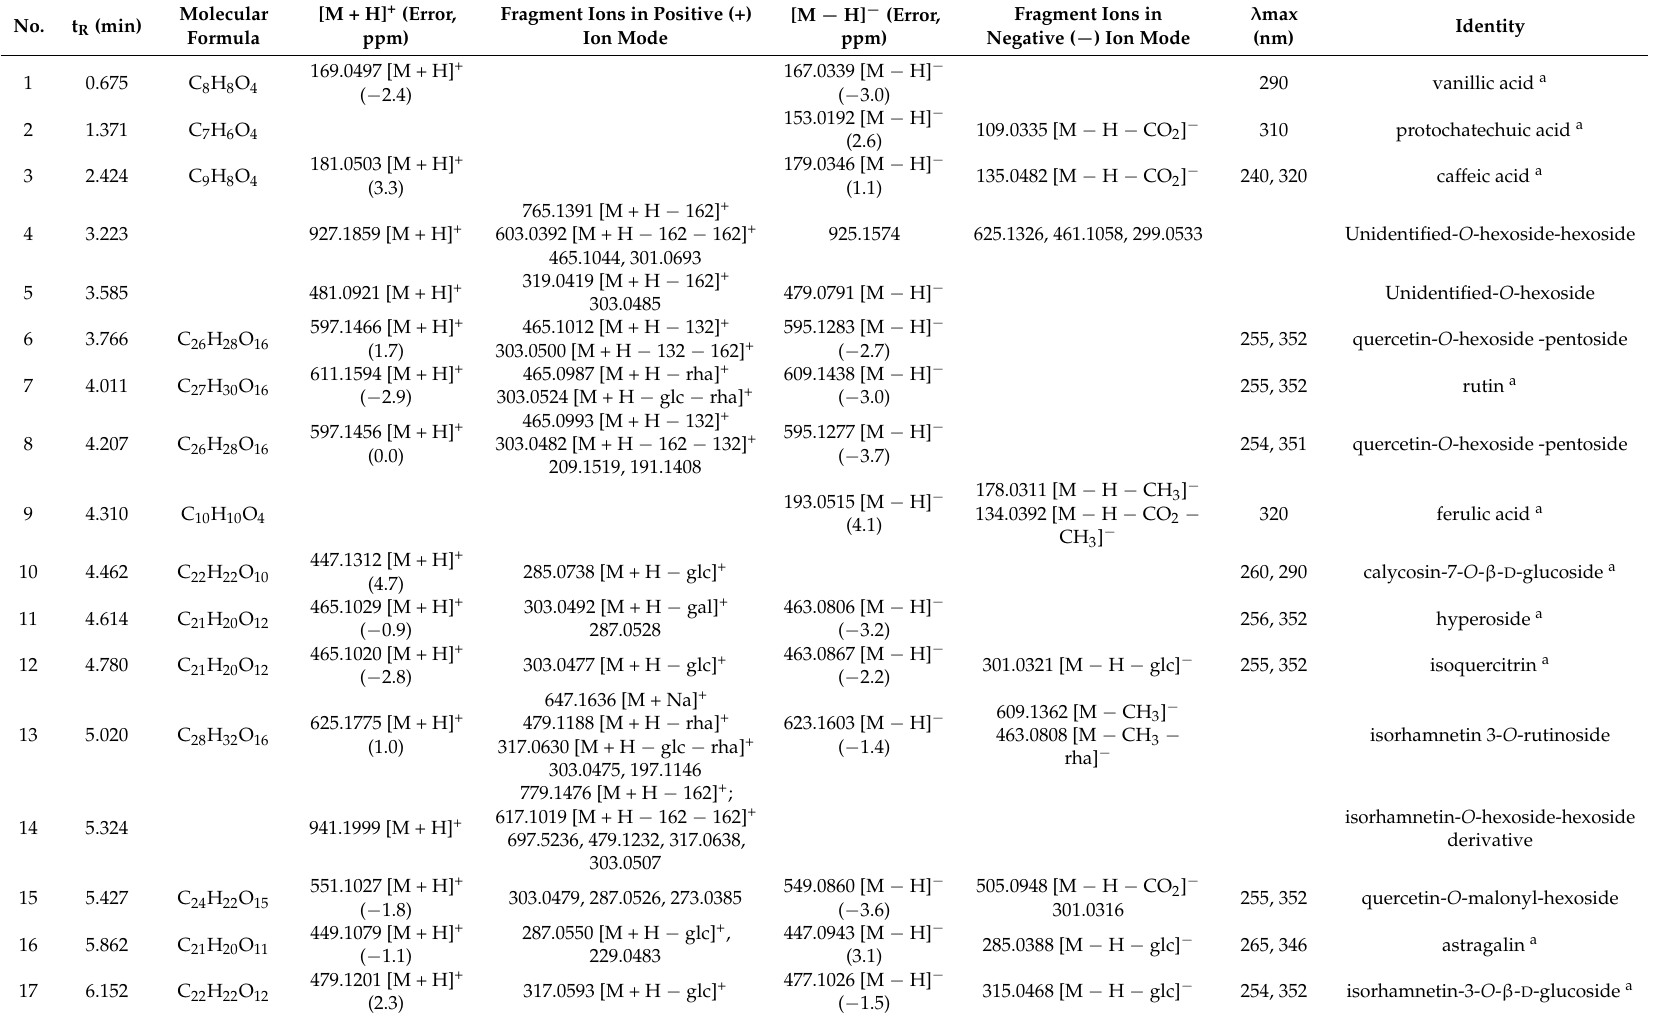
Table 1. Compounds identified in ME of AMF by UPLC-Q-TOF MS